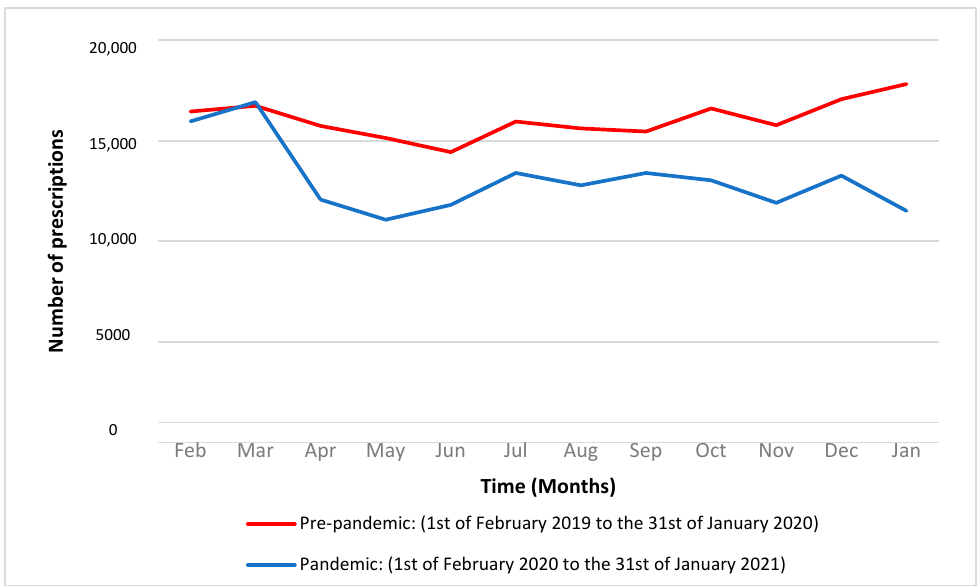
Figure 1. Antibiotic prescribing rates each month before and during the COVID-19 pandemic.